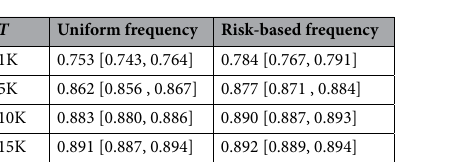
Table 4. Effect of uniform and risk-based testing frequency on mean and range of f S